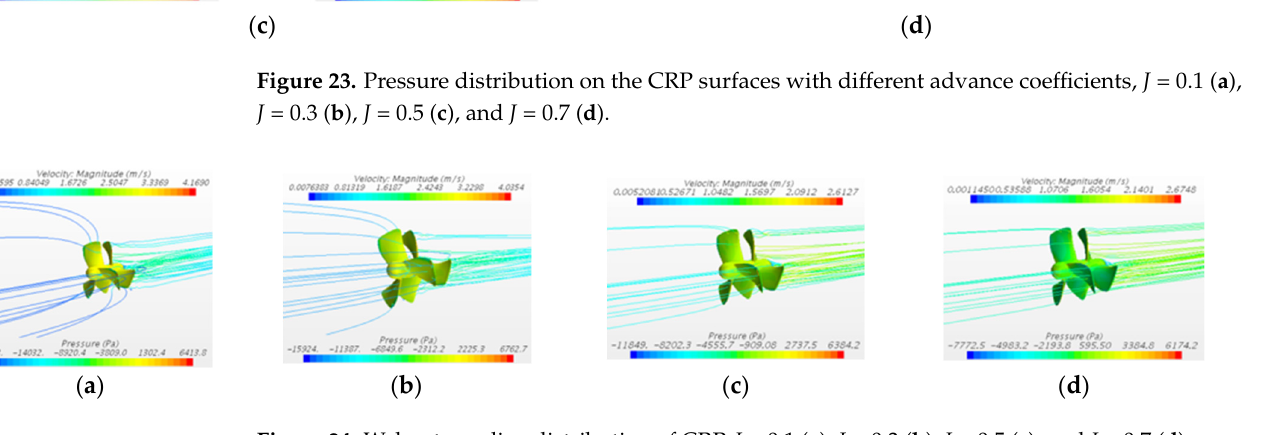
Figure 24. Wake streamline distribution of CRP, J = 0.1 ( a ), J = 0.3 ( b ), J = 0.5 ( c ), and J = 0.7 ( d ).